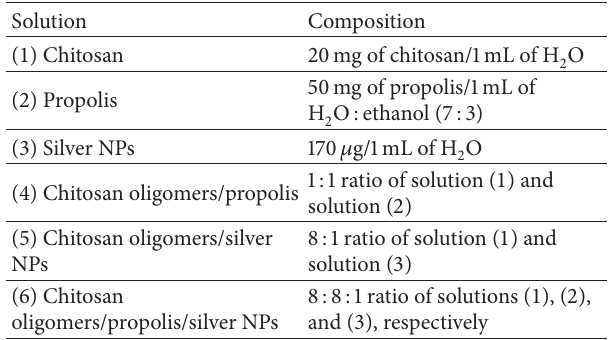
Table 1: Composition of each of the solutions mixed with MEA for the antifungal activity